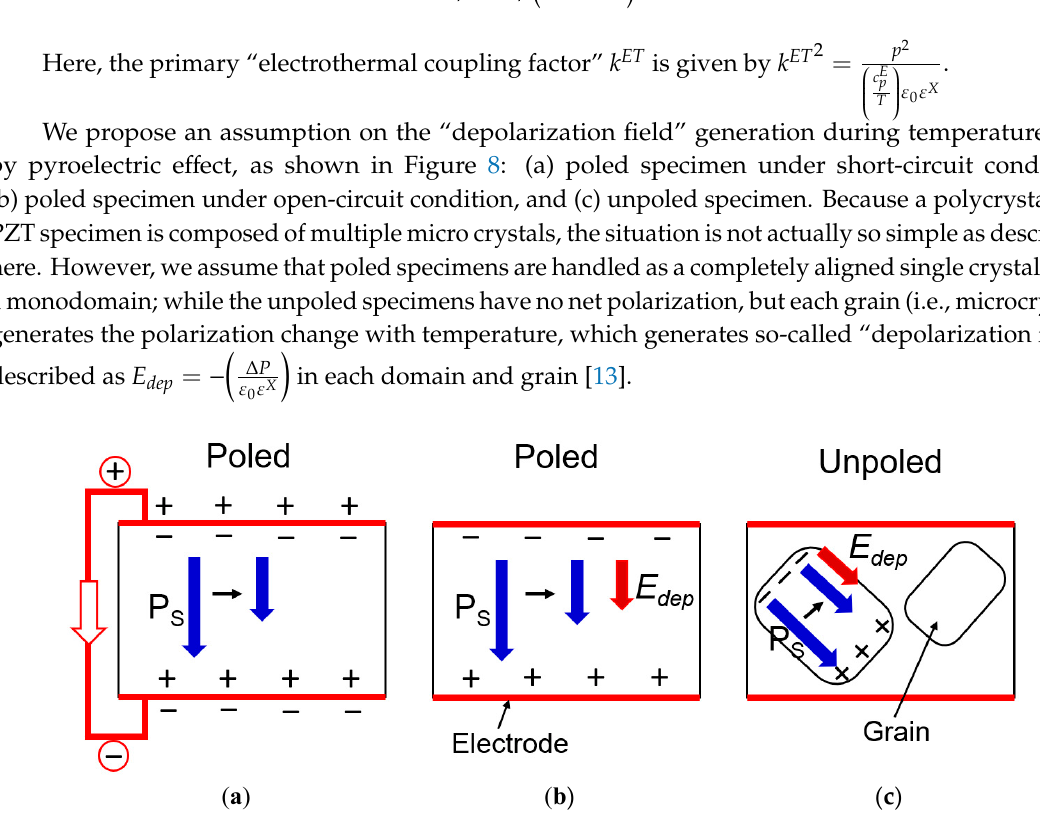
Figure 8. Depolarization field generation during temperature rise by pyroelectric effect: ( a ) poled specimen under short-circuit condition, ( b ) poled specimen under open-circuit condition, and ( c ) unpoled specimen.